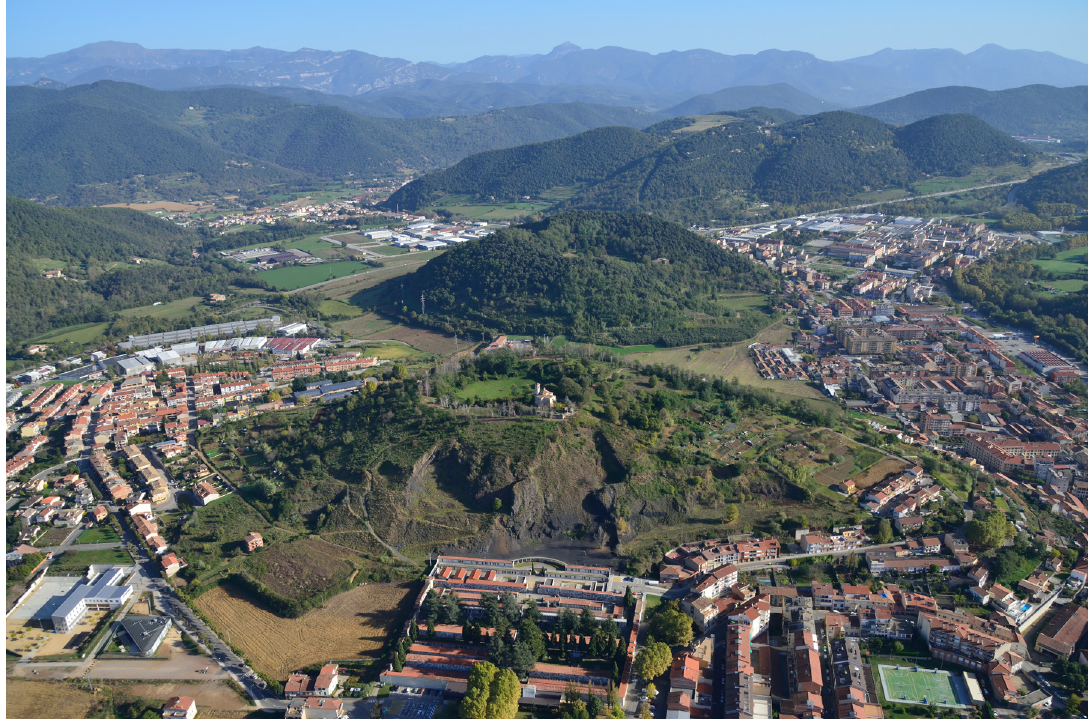
Figure 3: Montsacopa ( front ) and Garrinada ( back ) volcanoes, around 2018. Source: Photo courtesy of Eduard Masdeu